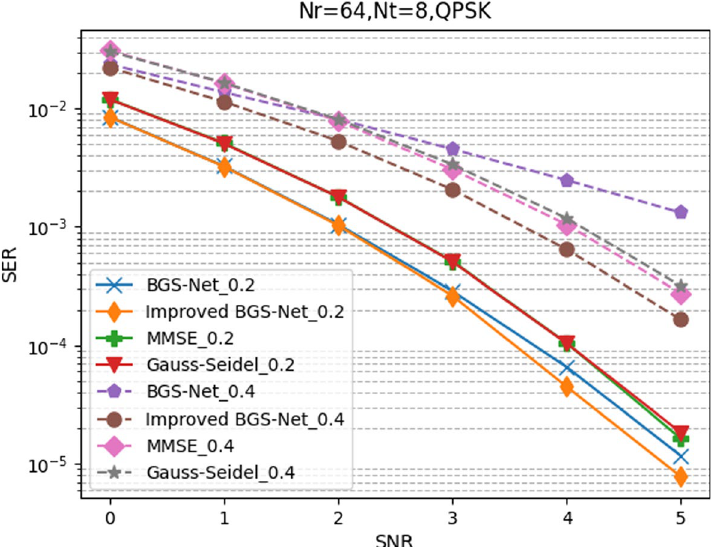
Fig. 24 SER performance comparison for N t = 8,N r = 64 , QPSK, MAUE system with ξ r = 0, ξ t = 0.2 or